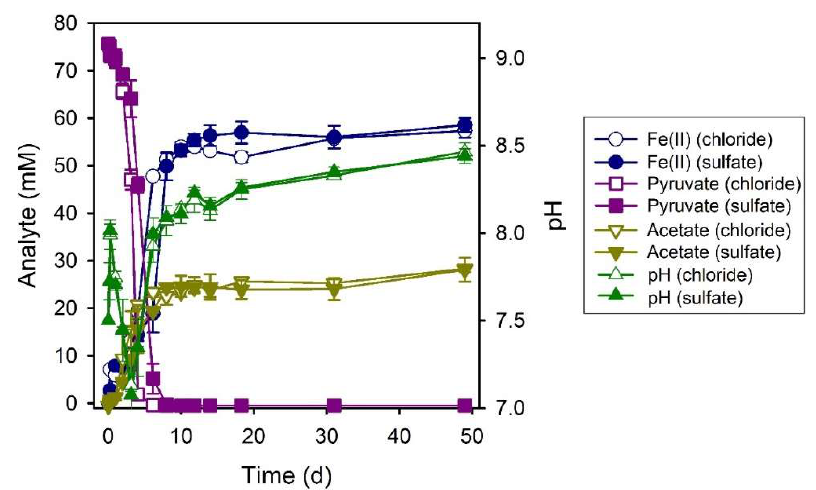
Figure 12. Fe(II) and acetate production, pyruvate consumption, and pH during the bioreduction of lepidocrocite by S. putrefaciens CN32 with pyruvate as the electron donor. Minerals 2019 , 9 , x FOR PEER REVIEW